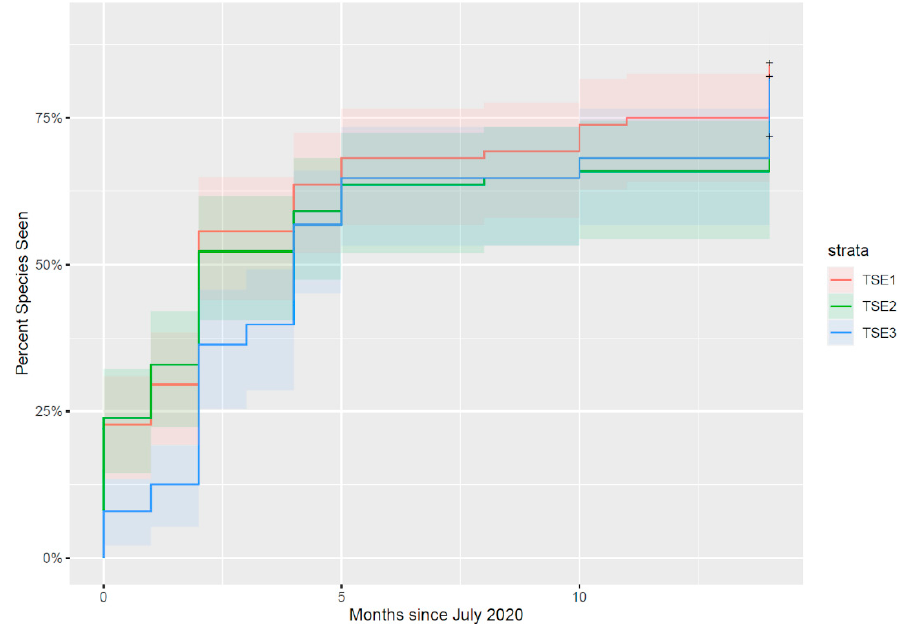
Figure 11. Species accumulation curves showing the cumulative number of species observed over time after rehabilitation for each treated sewage effluent pond (TSE; July 2020 = month 0). TSE ponds did not differ significantly in how quickly species accumulated (chi-squared = 2.57, df = 2, p = 0.28). The line shows when new species were observed, and the shading indicates 95% confidence intervals around observation time.